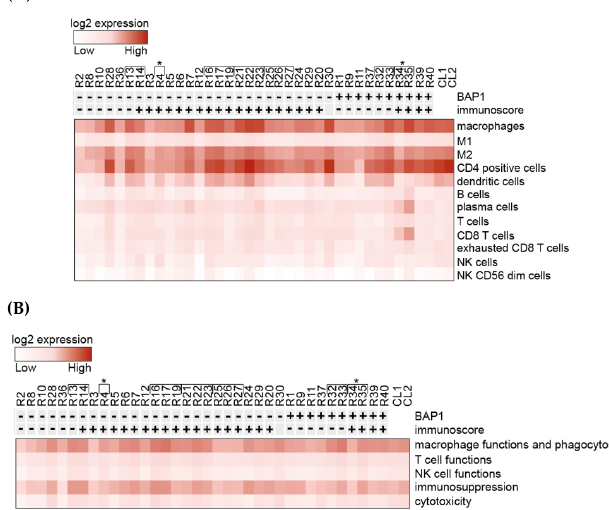
Figure 1. Heatmaps generated from normalized data post-NanoString analysis of gene expression. All metastatic uveal melanoma (mUM) cases were sorted by nuclear BAP1(nBAP1) status and total immunoscore (previously described, where total immunoscore of “0–3” i.e., “cold” tumours are shown as “-” and “4–6” i.e., “hot” tumours are marked “+.”) ( A ) Analysis of the relative participation of immune cell types/cell type profiling within the mUM tumour microenvironment. ( B ) Analysis of the gene profiles characteristic for the indicated cell functions. Key: [ indicates tumours from the same patient. *R4, R34, and R35 were samples from the same patient, with a 6-year difference between the two metastasectomies. CL1 is control liver samples pool 1 and CL2 is control liver samples pool 2. (Lists of genes included in each category for ( A ) and ( B ) are available in Figure S3A,B, respectively (as defined by NanoString, Figueiredo et al. [26] and Waks et al.